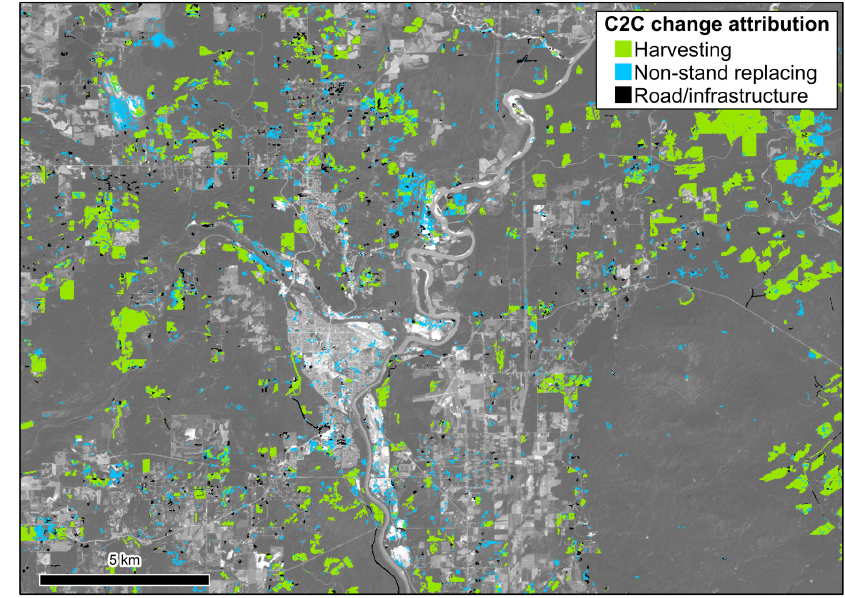
Figure 2. C2C (Composite2Change) forest change data between 1984 and 2003.